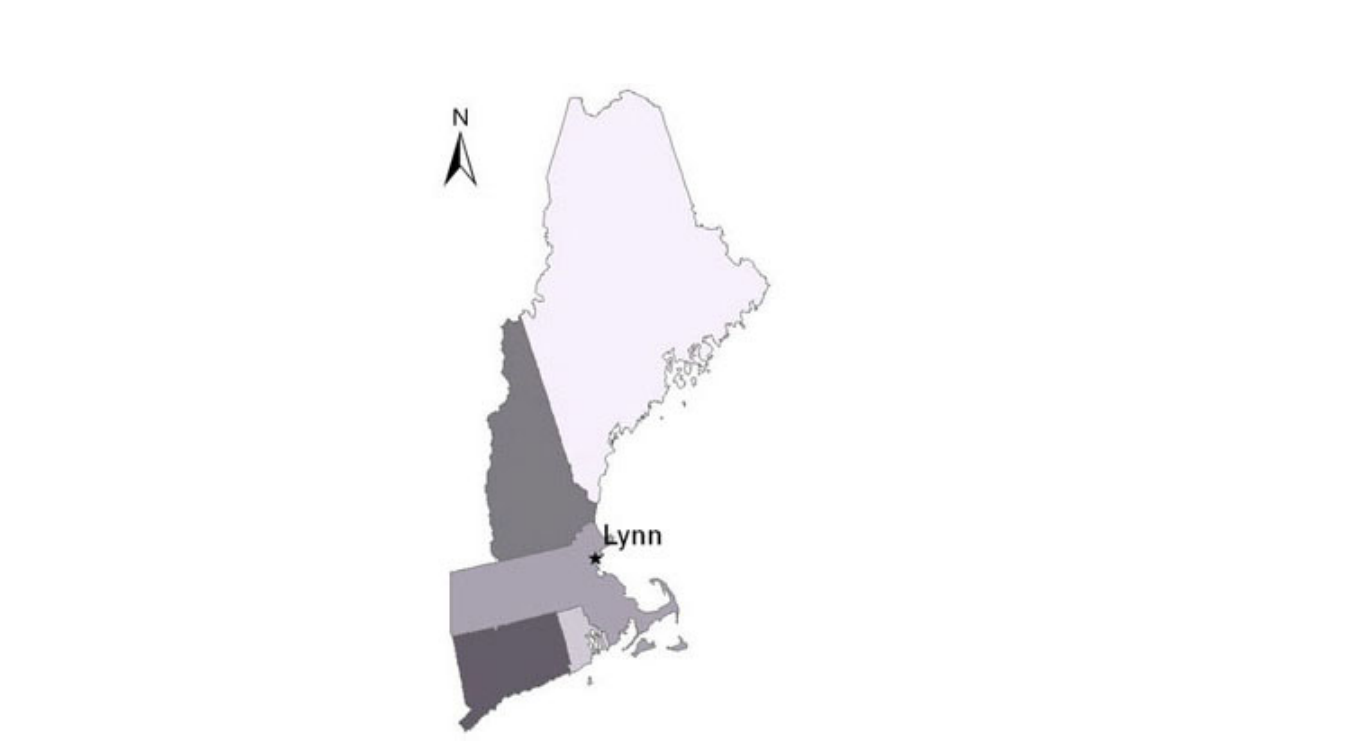
Fig. 1. Mean center for 2003–2006 NEFMC